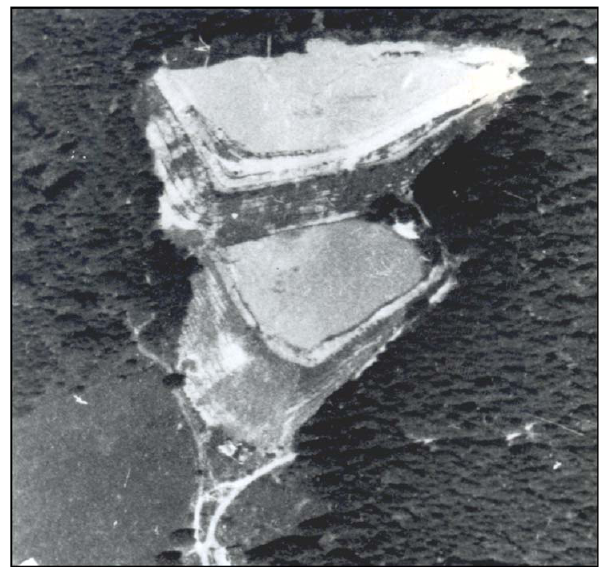
Fig. 7 ‐ The Pozzole basins in the summer 1983. Fig. 7. The Pozzole basins in the summer 1983. The top of the upper embankment appears amply broadened and leveled. Also no- ticeable is the development of the delta deposit at the left end of the upper basin, next to the place of cyclone operation (photo Impresa Rossi, Brescia).